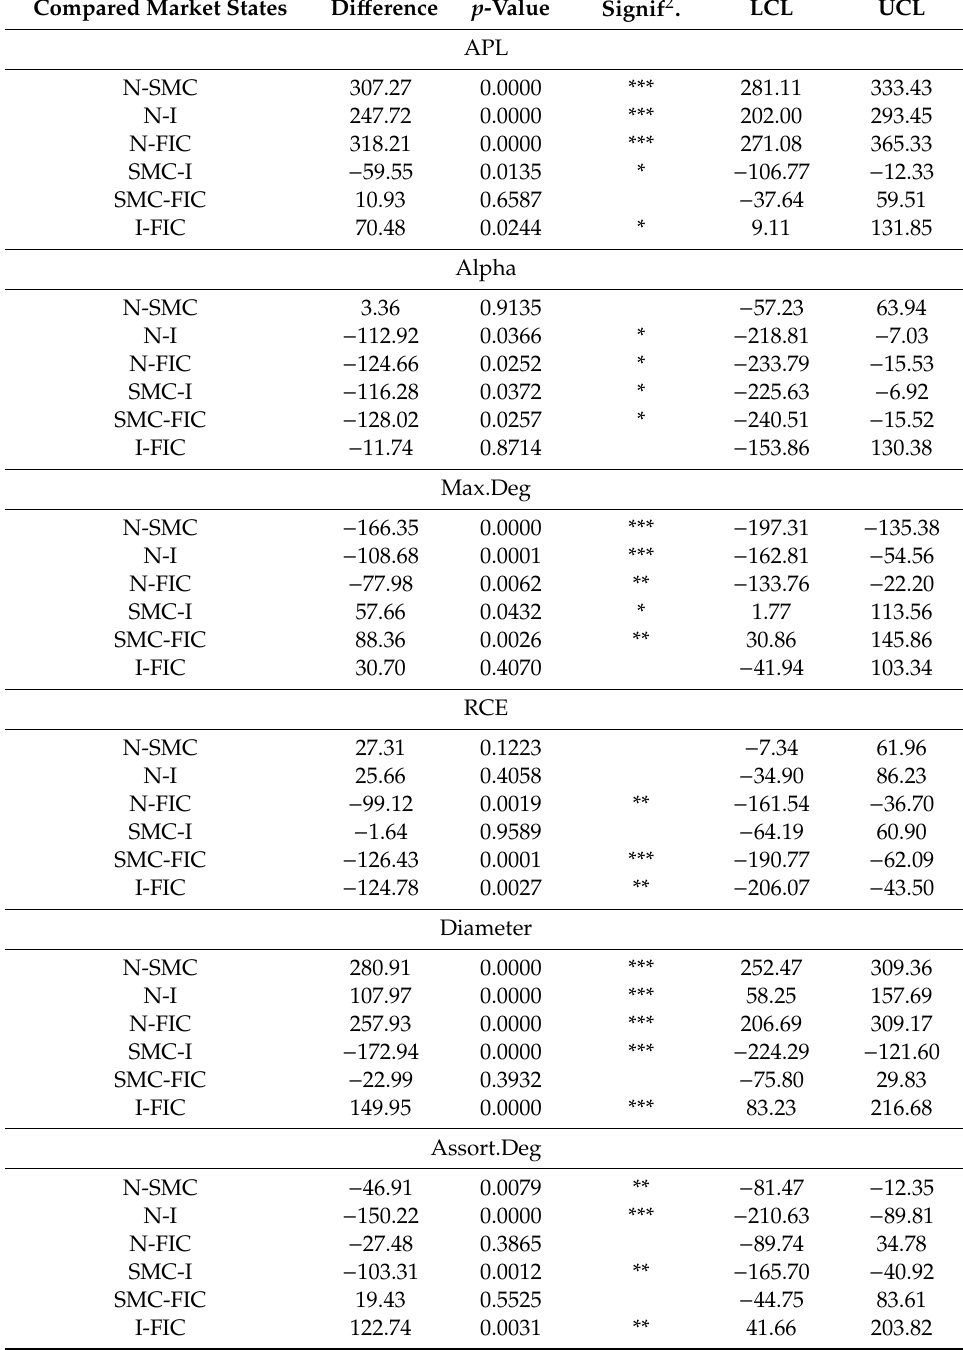
Table 2. Post-hoc analysis results (Conover–Inman